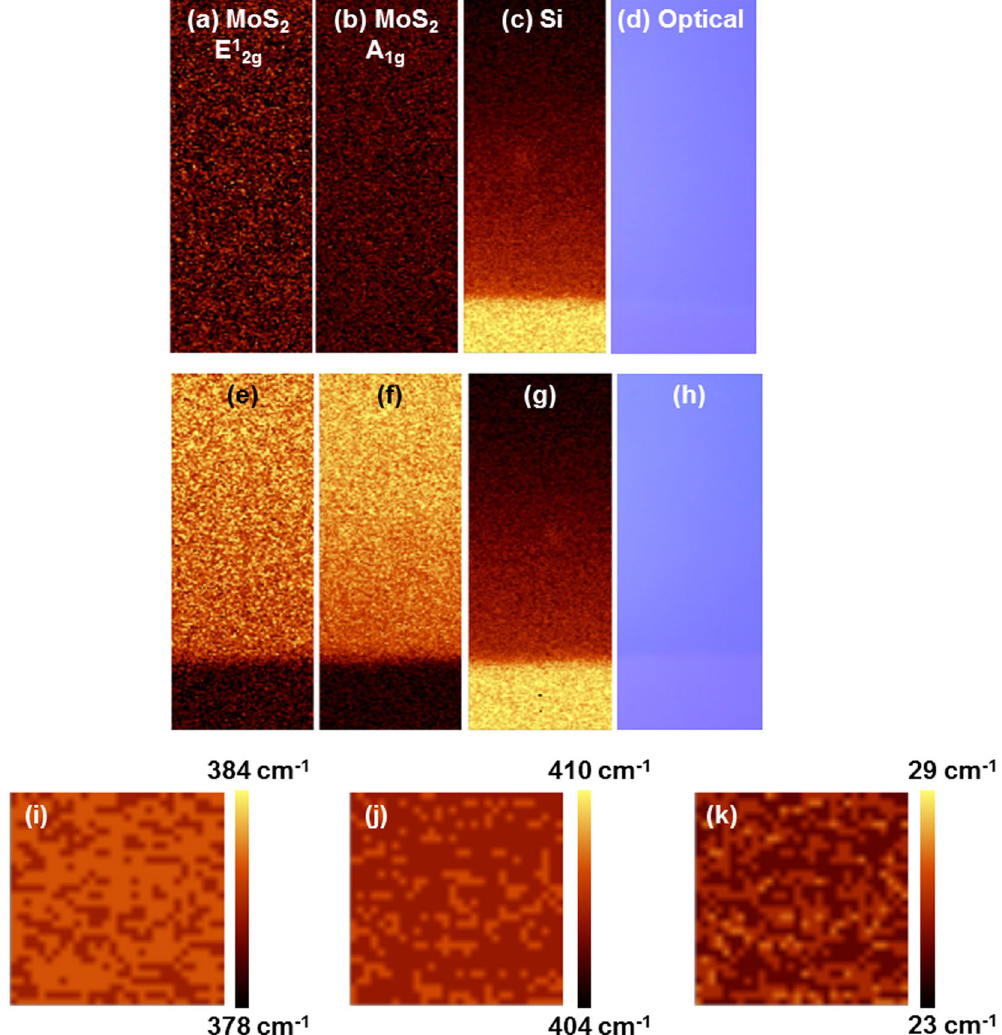
Figure 2. Raman mapping of samples ( a–h ) at the edge and ( i–k ) at the centre of the MoS 2 films. ( a – d ) as- deposited samples and ( e – h ) samples treated with EBI for 1 min at the edge of MoS 2 (20 µ m × 50 µ m). ( a , e ) E 1 2g mode, ( b , f ) A 1g mode, and ( c , g ) Si peaks were scanned at 375–385, 405–411, and 517–523 cm − 1 , respectively. ( d , h ) Optical images of scanned area. ( i – k ) Raman mapping of the peak position for the 1 min EBI-treated sample at the centre of